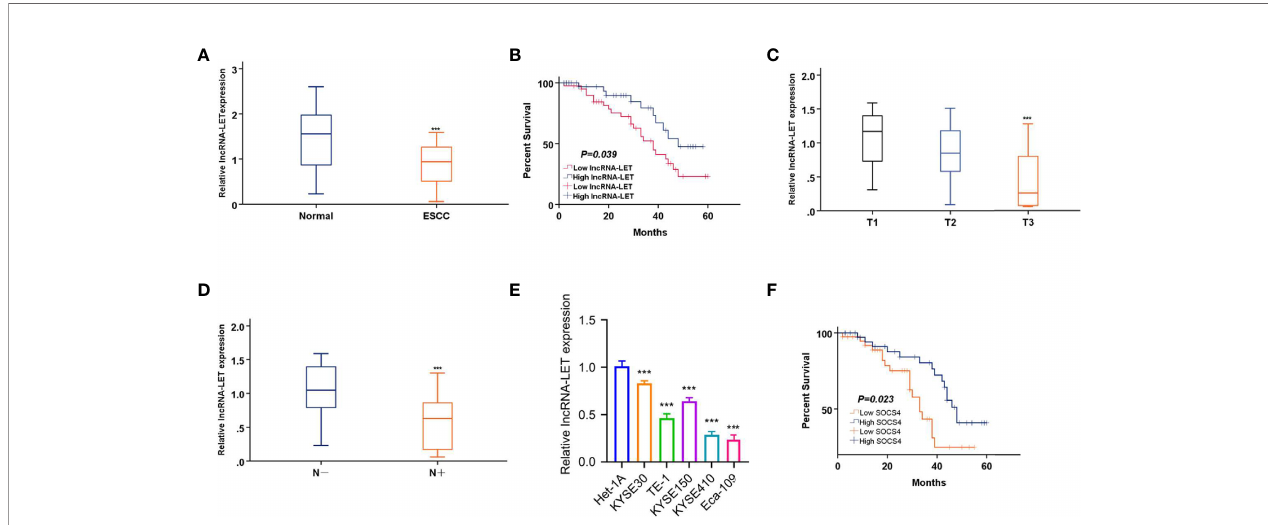
FIGURE 1 | (A) lncRNA-LET expression within esophageal squamous cell carcinoma (ESCC) and matched non-carcinoma samples was measured by qRT-PCR. (B) The overall survival (OS) rate in cases showing lncRNA-LET downregulation ( n = 40) and lncRNA-LET upregulation ( n = 40) was analyzed by the Kaplan – Meier plot. (C) lncRNA-LET expression in different clinical T stages was measured by qRT-PCR. (D) lncRNA-LET expression within clinical LN-negative and LN-positive was measured by qRT-PCR. (E) lncRNA-LET expression in ESCC cell lines and the normal cell het-1a was measured by qRT-PCR. (F) The OS rate in cases showing SOCS4 downregulation ( n = 40) and SOCS4 upregulation ( n = 40) was analyzed by the Kaplan – Meier plot. *** P <